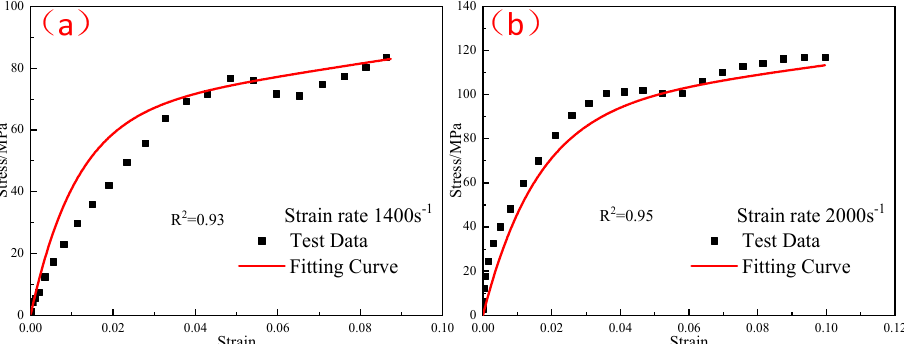
Figure 20. Comparison of the fitting results of the ZWT constitutive model with the experimental results under different strain rates at − 30 °C: ( a ) 1400 s − 1 ; ( b ) 2000 s − 1 .